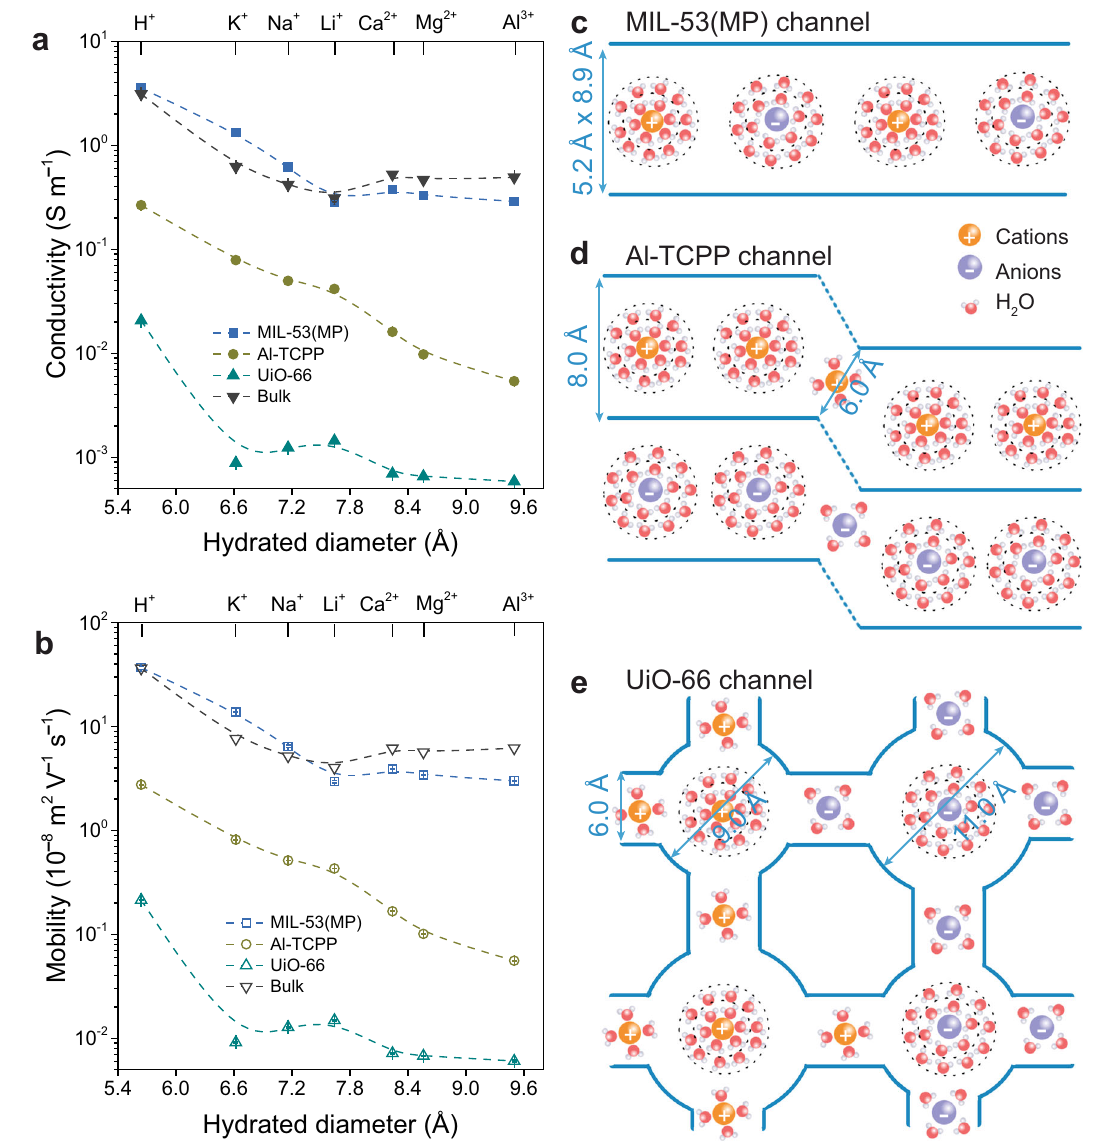
Fig.3|CationstransportpropertiesinMOFchannels.a Conductivitiesofcations in MOF and bulk solution. b Mobilities of cations in MOF channels and bulk solu- tion. Error bars represent the standard deviation of three measurements of a